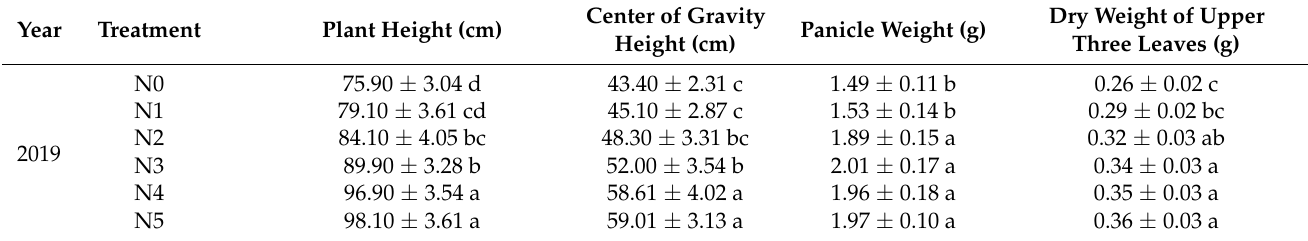
Table 3. Effect of N application rate on main stem characteristics of rice under dry cultivation in 2019 and